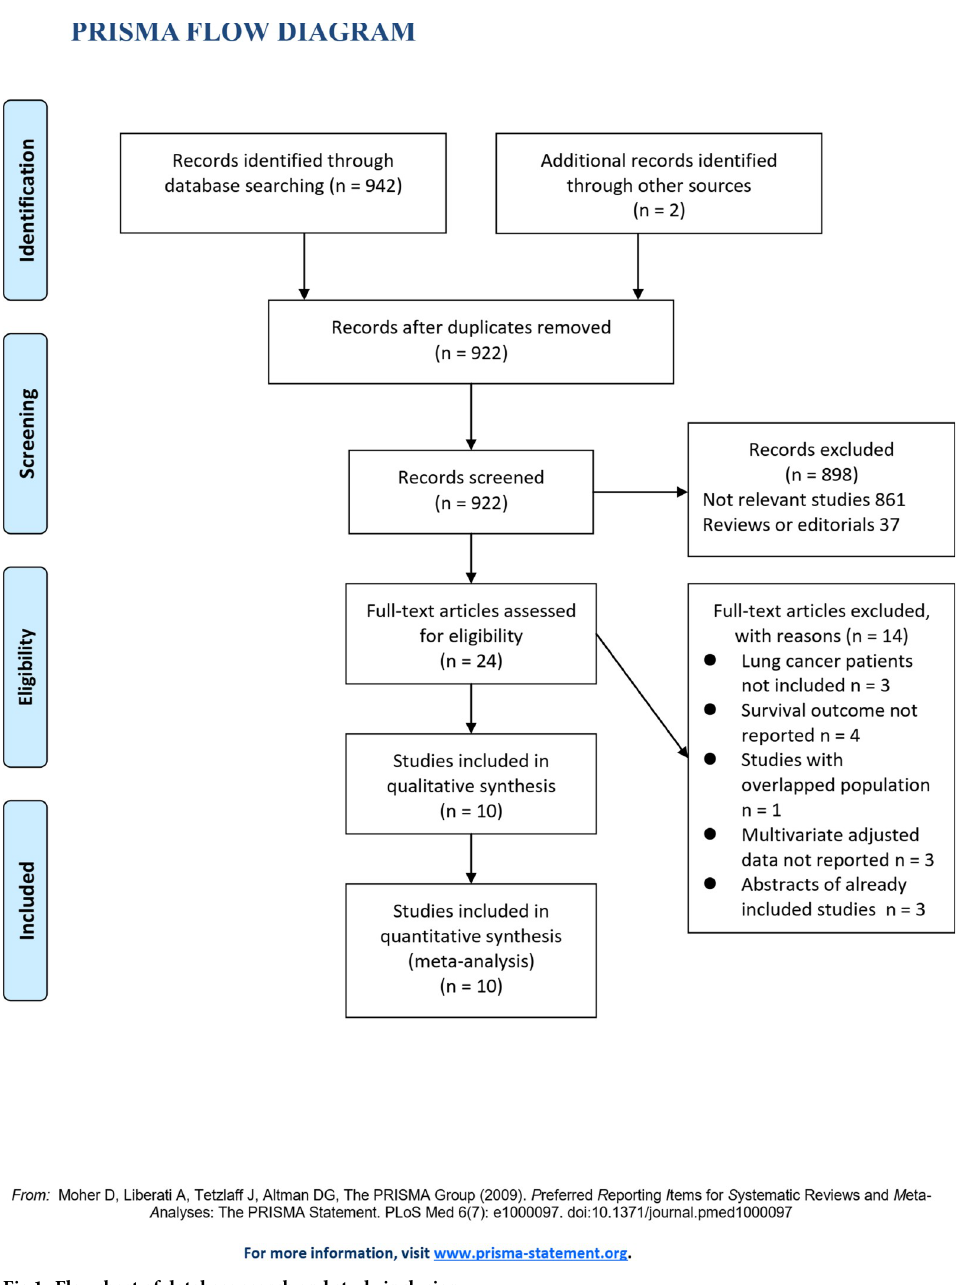
Fig 1. Flowchart of database search and study